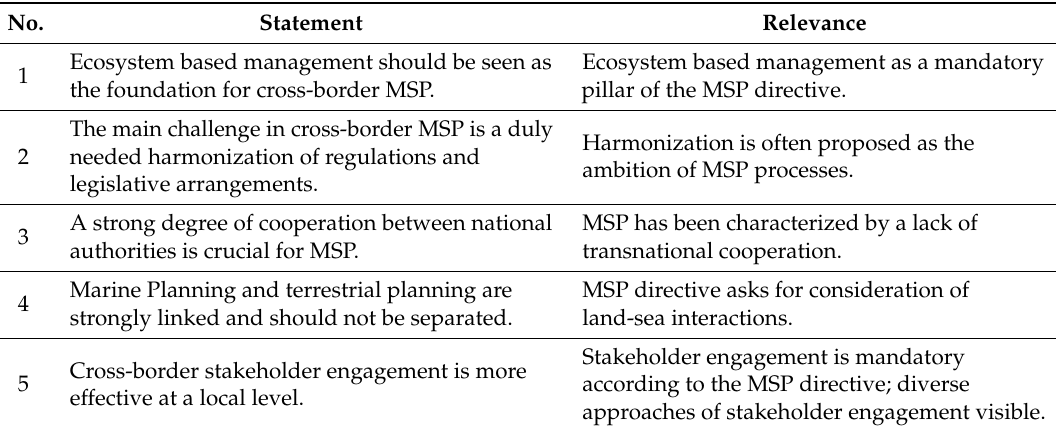
Table 2. Five MSP statements of a ‘Living Q’ exercise tailored for an international audience discussing MSP. The relevance of statements relate to key elements of